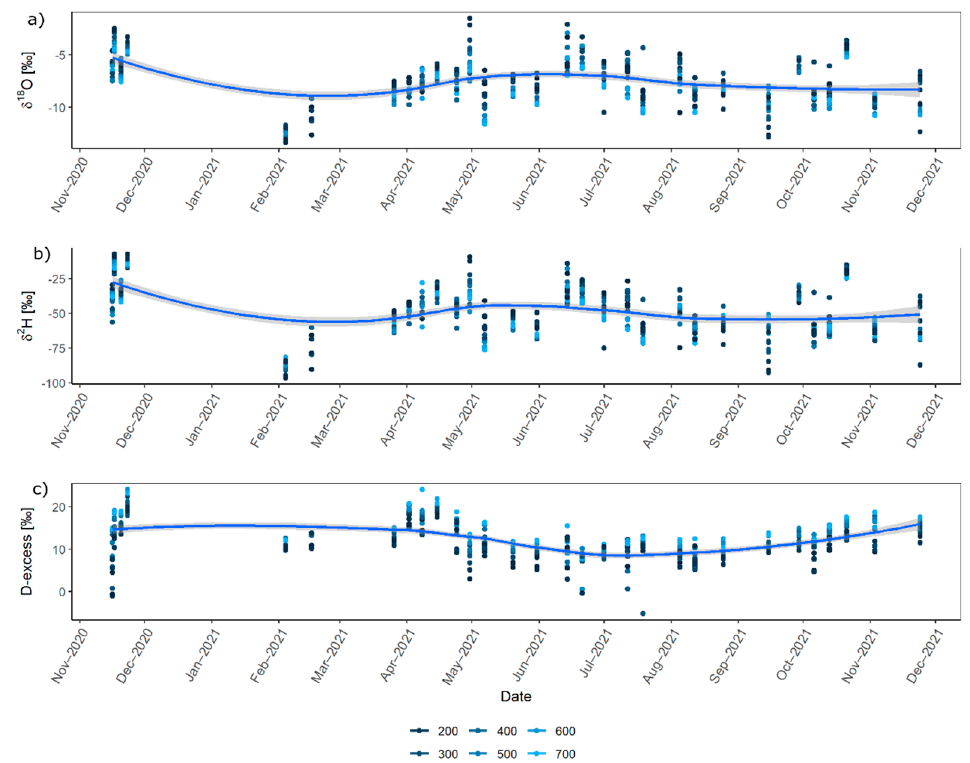
Figure 2. The isotopic composition of δ 18 O ( a ), δ 2 H ( b ), and D-excess ( c ) variation with the time in the elevation profile. The blue lines are effectively aliases to display the patterns of the data with a non-standard geometric object and the grey shadings represent the 95% confidence interval of those lines.